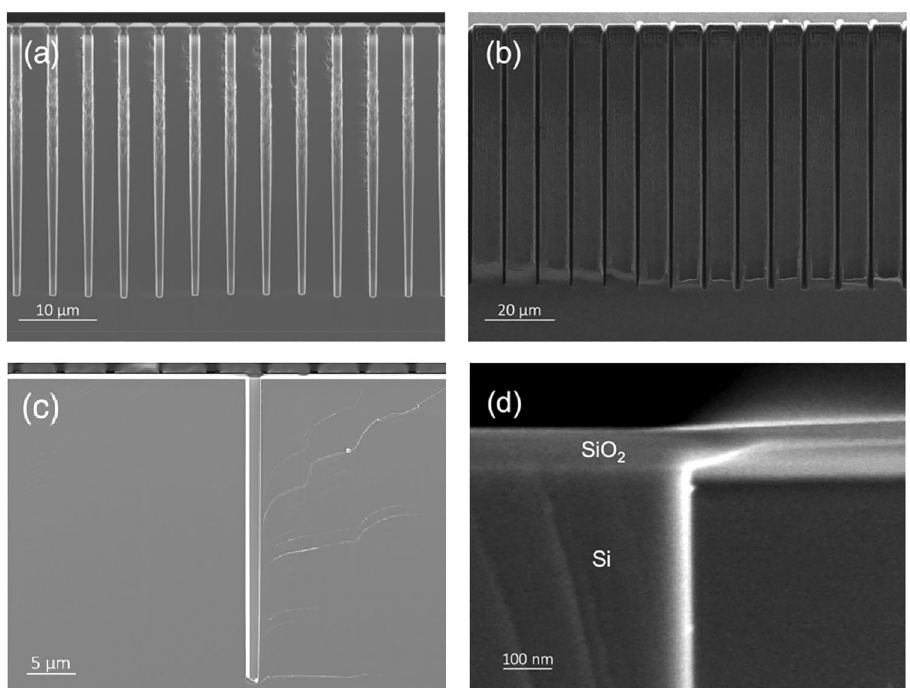
Figure 2. Scanning electron micrograph of TSV holes ( a ) and trenches ( b ) fabricated with the optimized deep reactive ion etching. The width of the hole presents non-negligible bowing effect, going from a minor diagonal size of 1 µm at the top, ~ 1.15 µm in the middle and 0.8 µm at the bottom. Scanning electron micrograph of the Michelangelo-processed TSV hole with an AR of 28:1 ( c ). After KOH etching, bowing in drastically reduced, giving a slightly wider but constant 1.1 µm minor diagonal width at the top and middle of the TSV, dropping to 1 µm at the bottom. Particular of the surface roughness of the TSV after Michelangelo process ( d